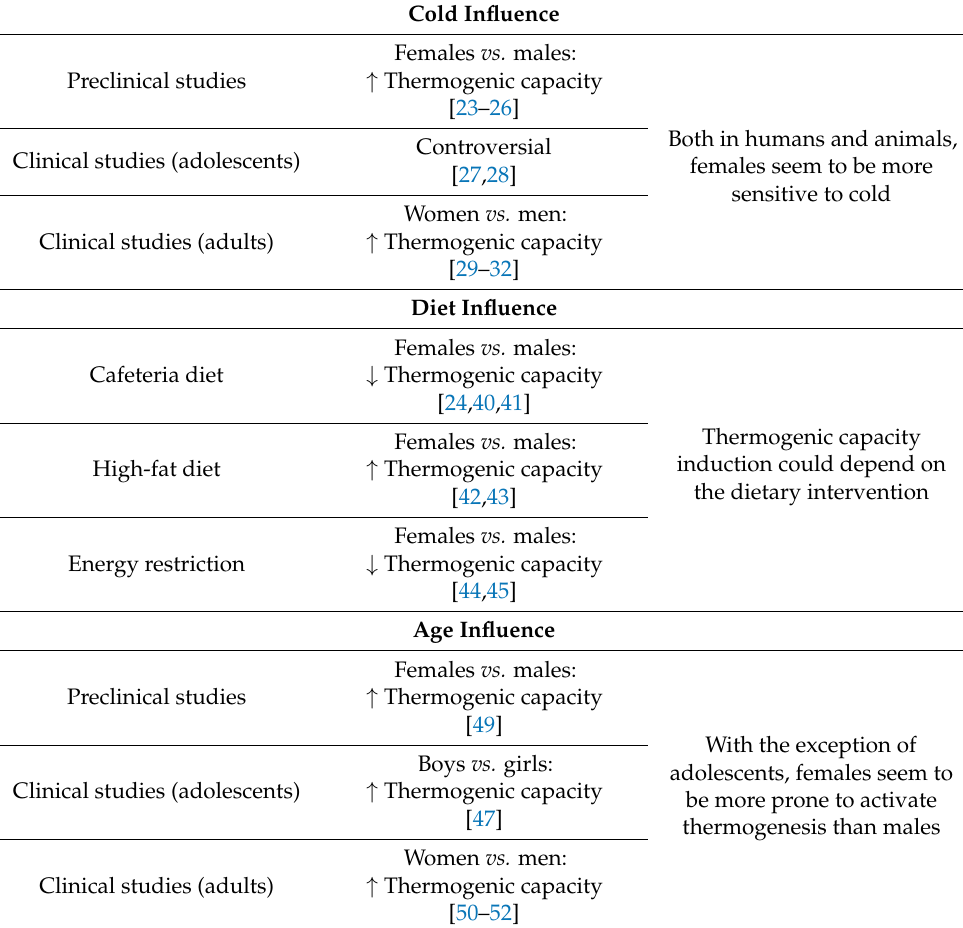
Table 5. Summary of the main sex differences observed in the reported